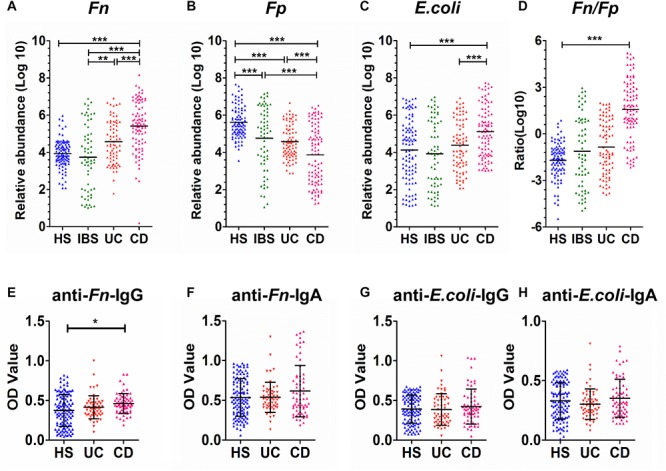
Quantitative detection of fecal and sera microbial markers in CD patients and control groups. (A–D) The relative fecal abundances of F. nucleatum (Fn) (A), F. prausnitzii (Fp) (B), and E. coli
(C) ratio of Fn to Fp (Fn/Fp) (D) in 346 individuals, including 65 patients with IBS, 95 patients with Crohn’s disease (CD), 81 patients with ulcerative colitis (UC) and 105 healthy subjects (HS). (E–H) Comparison of OD values of anti-Fn/E. coli-IgG or anti-Fn/E. coli-IgA in sera from healthy subjects (HS, n = 105) and patients with ulcerative colitis (UC, n = 65) and Crohn’s disease (CD, n = 58) were individually assayed. Symbols indicate individual OD values; horizontal lines indicate mean values ± SD. Differences between the three groups were analyzed by the Kruskal–Wallis test. (E) Anti-Fn-IgG; (F) anti-Fn-IgA; (G) anti-E. coli-IgG; (H) anti-E. coli-IgA. *P < 0.01, ∗∗P < 0.001, ∗∗∗P < 0.0001.